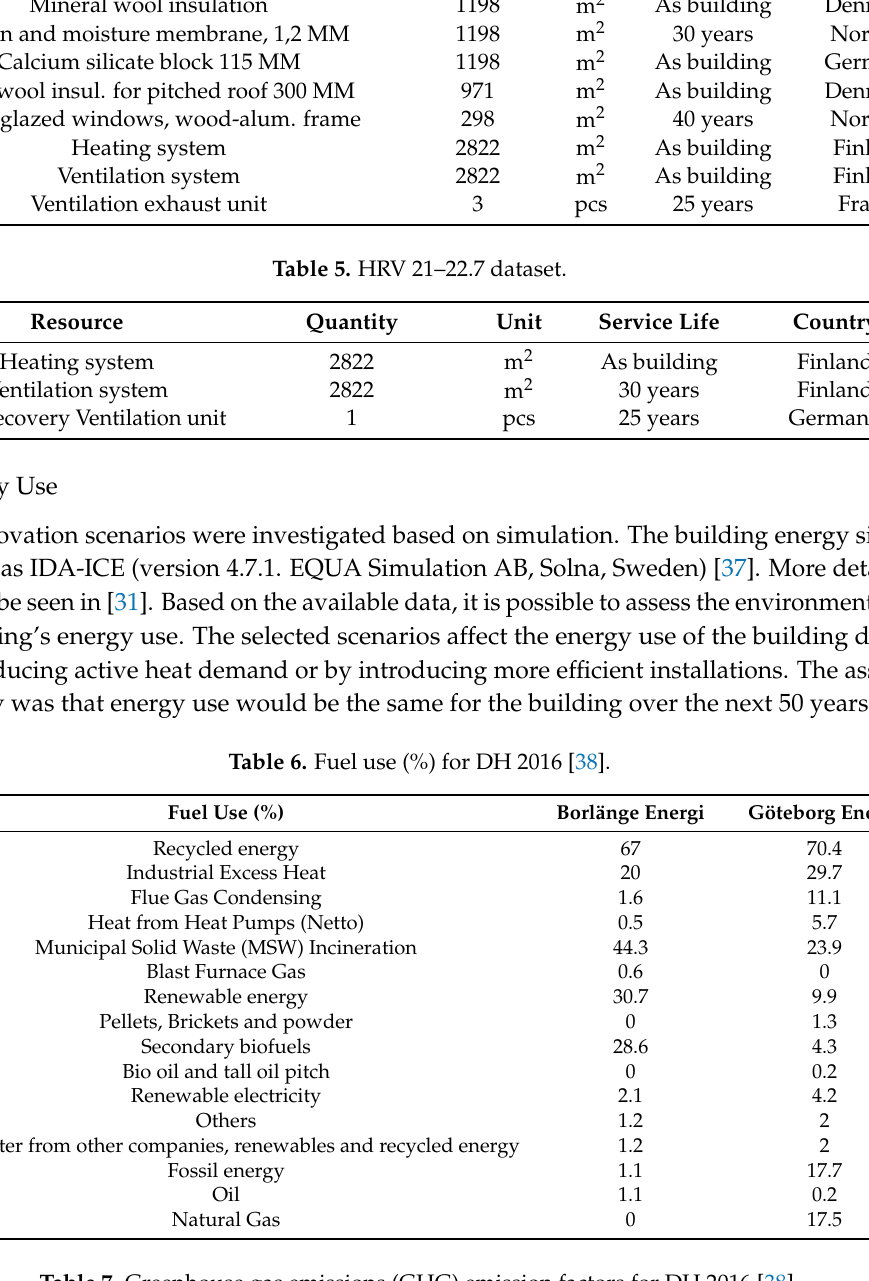
Table 7. Greenhouse gas emissions (GHG) emission factors for DH 2016